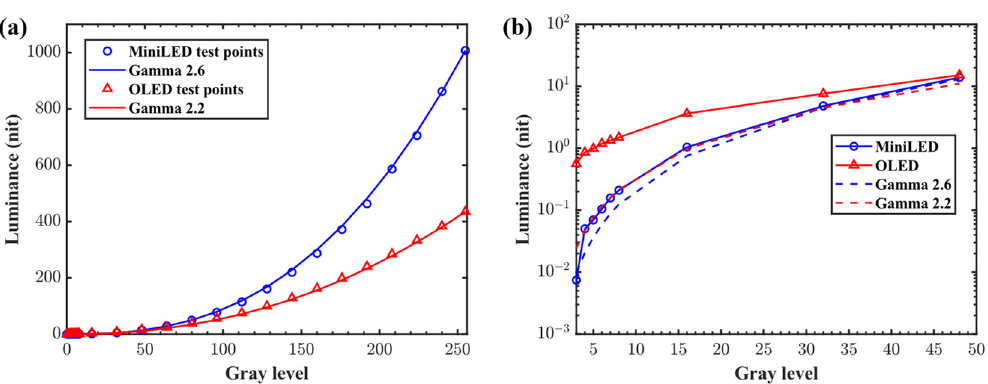
Figure 2. ( a ) Gamma curves for the mLCD and the OLED display and ( b ) gamma curves at low gray levels.